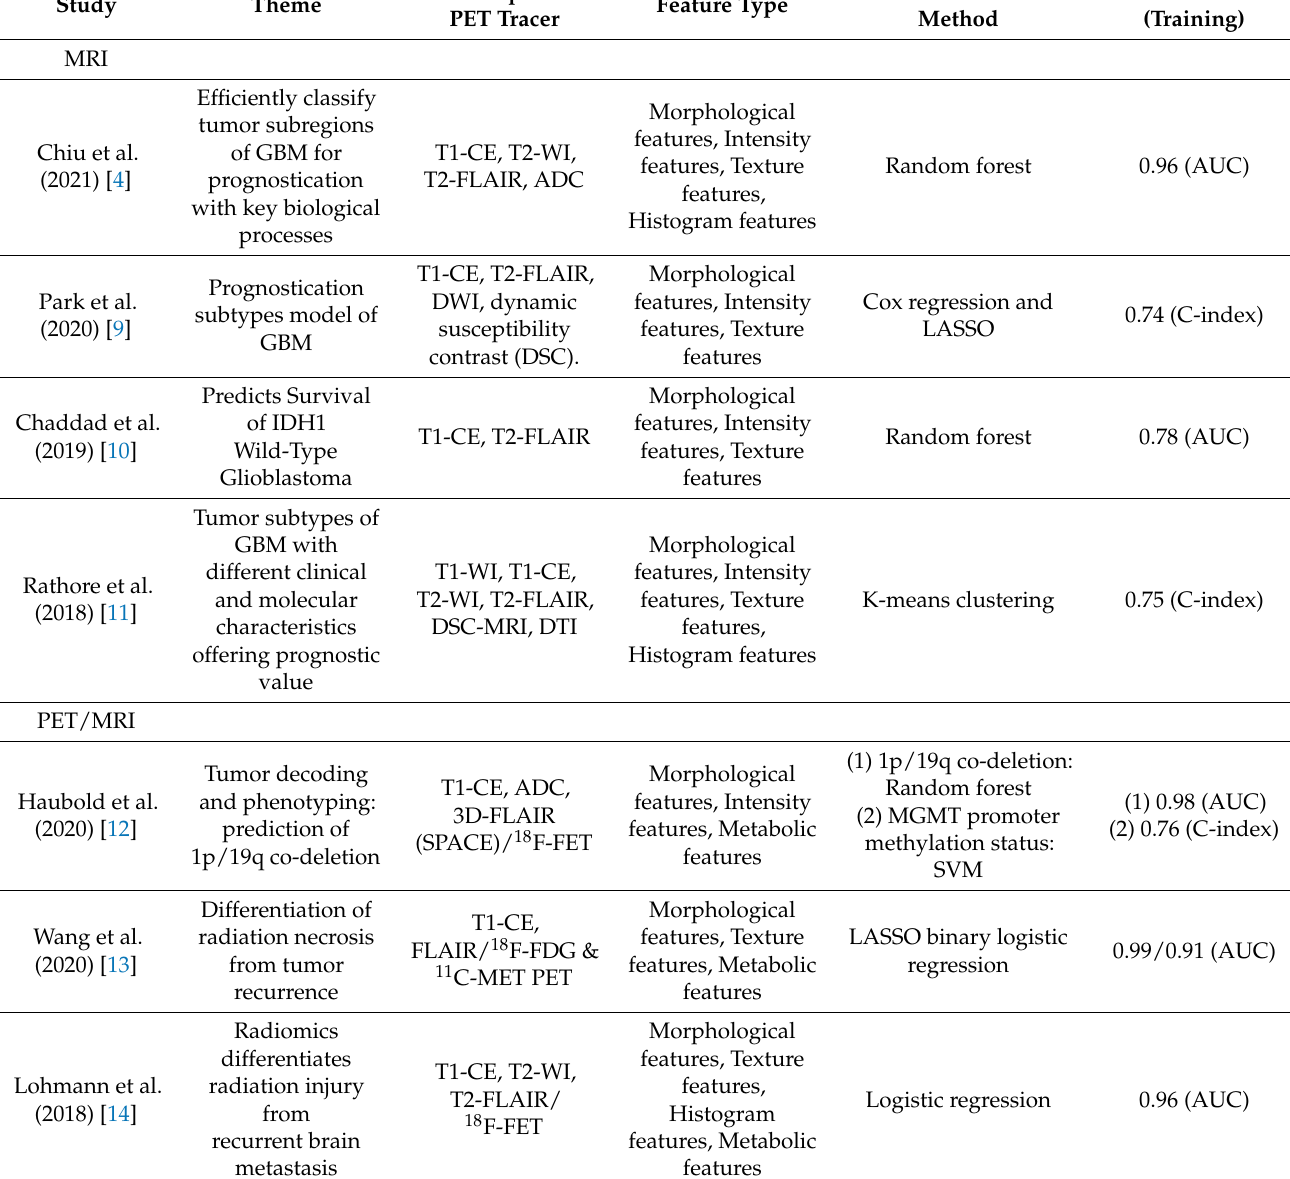
Table 4. The comparison of feature findings with MRI and PET/MRI based on radiomics